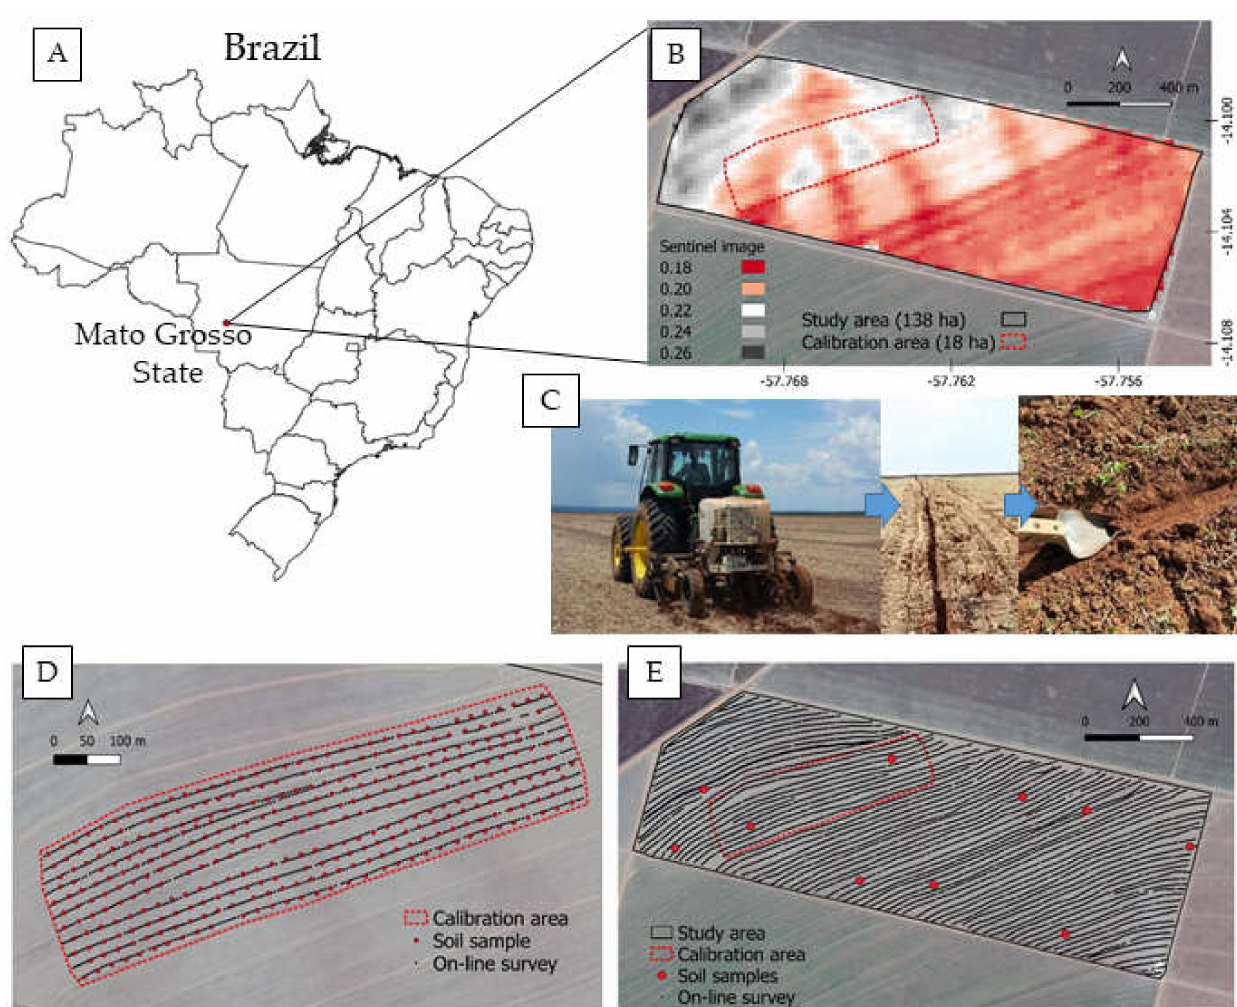
Figure 1. Schematic figure showing the location of the studied field ( A ); soil spatial variability observed in the Sentinel image ( B ); on-line soil survey conducted with the mobile vis–NIR platform and furrow left by the platform shank ( C ); soil sampling location and trajectory of on-line survey performed in the calibration area ( D ) and the entire field ( E